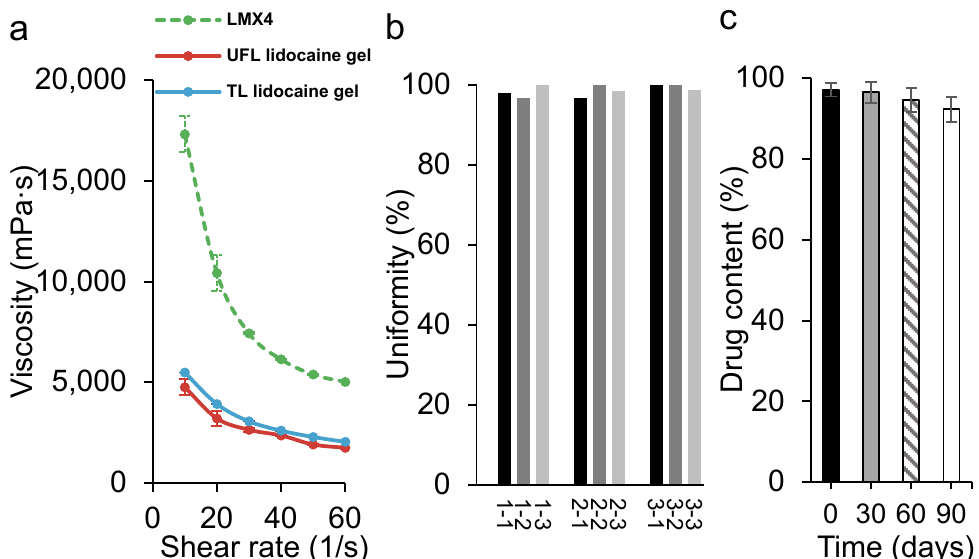
Figure 3. ( a ) The viscosity of LMX4 cream (green line) and the UFL (red line) and TL (blue line) lidocaine gels at 32 °C; ( b ) lidocaine content uniformity of the UFL lidocaine gel (three samples were taken from each batch of the gel; three batches were included); ( c ) stability of the UFL lidocaine gel over 3 months’ storage at 4 °C.